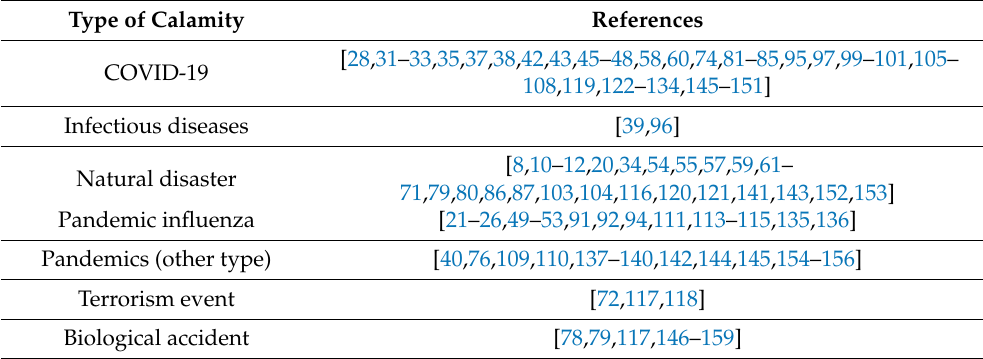
Table 6. Type of